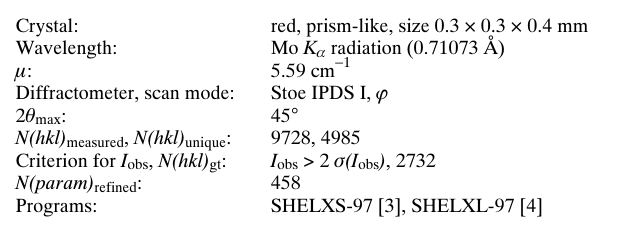
Table 4. Data collection and handling.